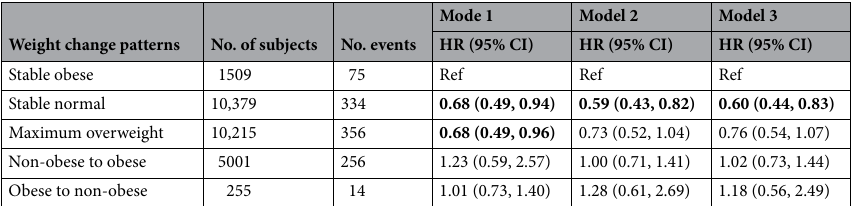
Table 3. Hazard ratios (HRs) and 95% confidence intervals (CIs) of incident asthma with weight change patterns across adulthood in NHANES 2001–2018 used the stable obesity category as a reference. All estimates accounted for complex survey designs and the analyses used the sample weights, stratification and clustering suggested by the CDC. Significant results are in boldface type. Model 1: Non-adjusted model. Model 2: Adjusted for age at 10 years before baseline, gender, race/ethnicity (Mexican American, non-Hispanic White, non-Hispanic Black, and other race). Model 3: Adjusted for age at 10 years before baseline, gender, race/ ethnicity (Mexican American, non-Hispanic White, non-Hispanic Black, and other race), baseline education level (less than high school, high school or equivalent, college or above), baseline family income (family income-poverty ratio, 0–1.0, 1.1–3.0, > 3.0), baseline smoking status (ever smoke and never smoke).